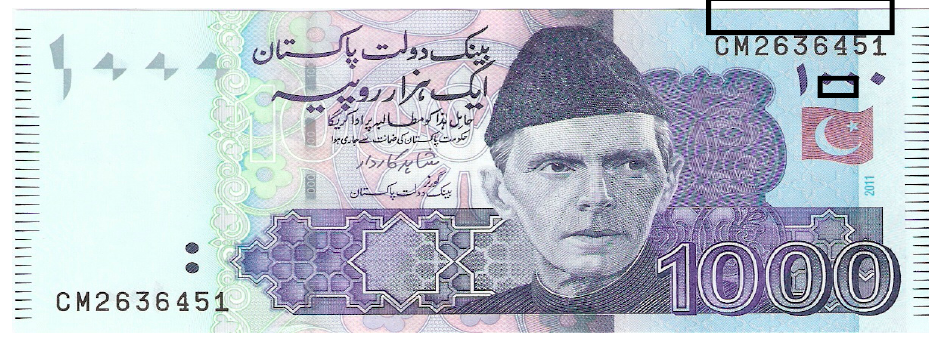
Figure 3. Selected portions in Rs.1000 used for XRD analysis.